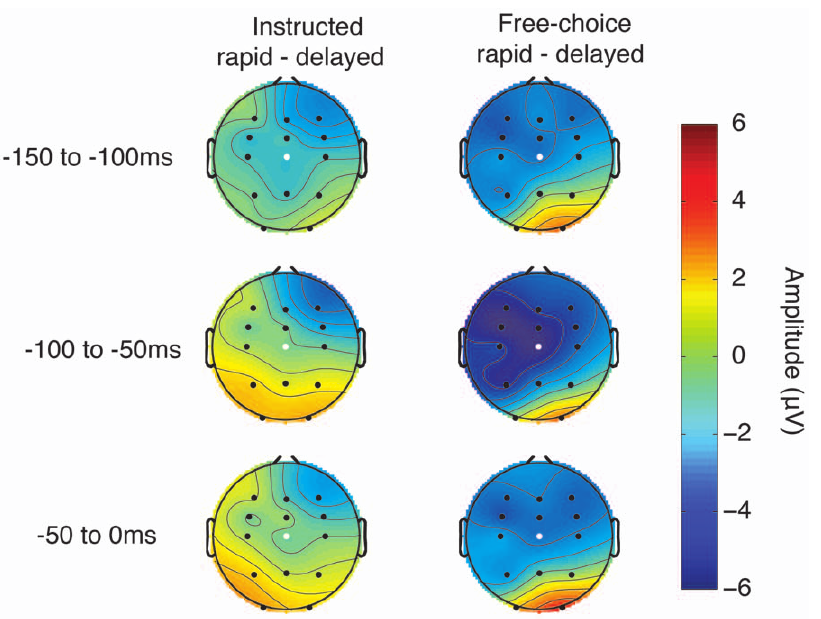
Figure 4. Differential topographical plots of ERPs. Topographical plots of the difference in brain activity between rapid and delayed trials. Depicted values are averaged amplitudes over 50 ms time windows. Note stronger difference in free-choice than in instructed conditions. White highlight shows electrode Cz, from which the mean time window amplitudes were obtained for statistical analyses.